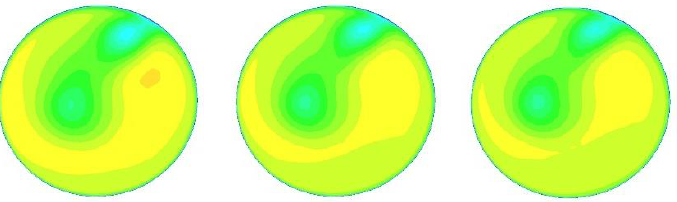
Figure 4. Velocity cloud diagrams at 2, 4, and 6 m/s at x = 15 cm (from left to right).